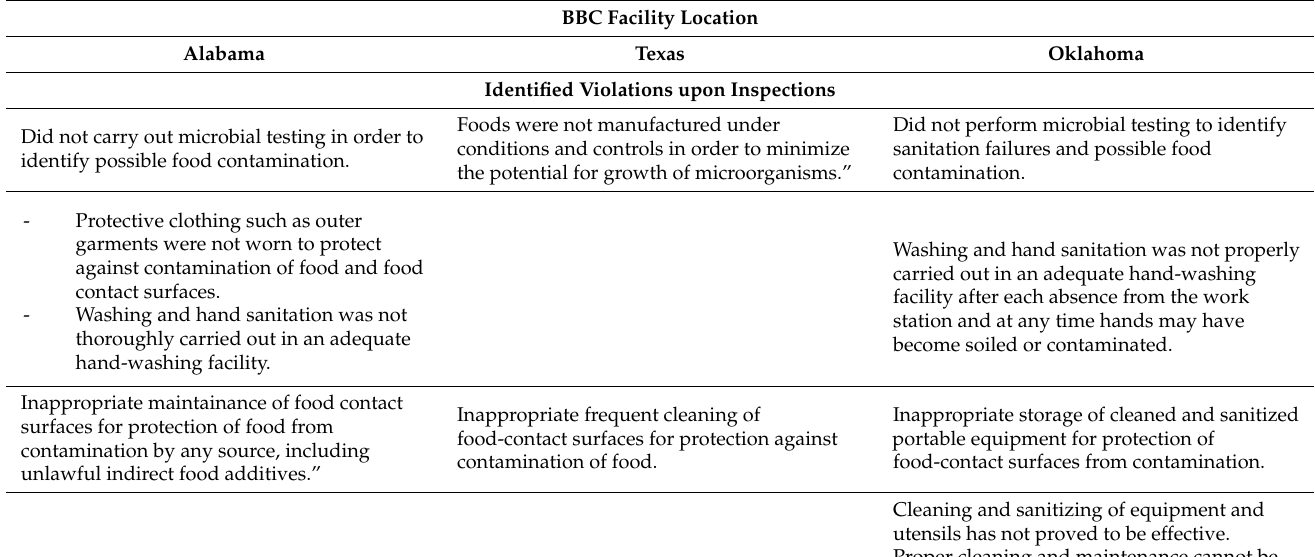
Table 5. Violations of HACCP-based Standard Operating Procedures (SOPs) identified by on-site FDA inspections Sources: US FDA Observation Reports on Blue Bell Creameries Facilities